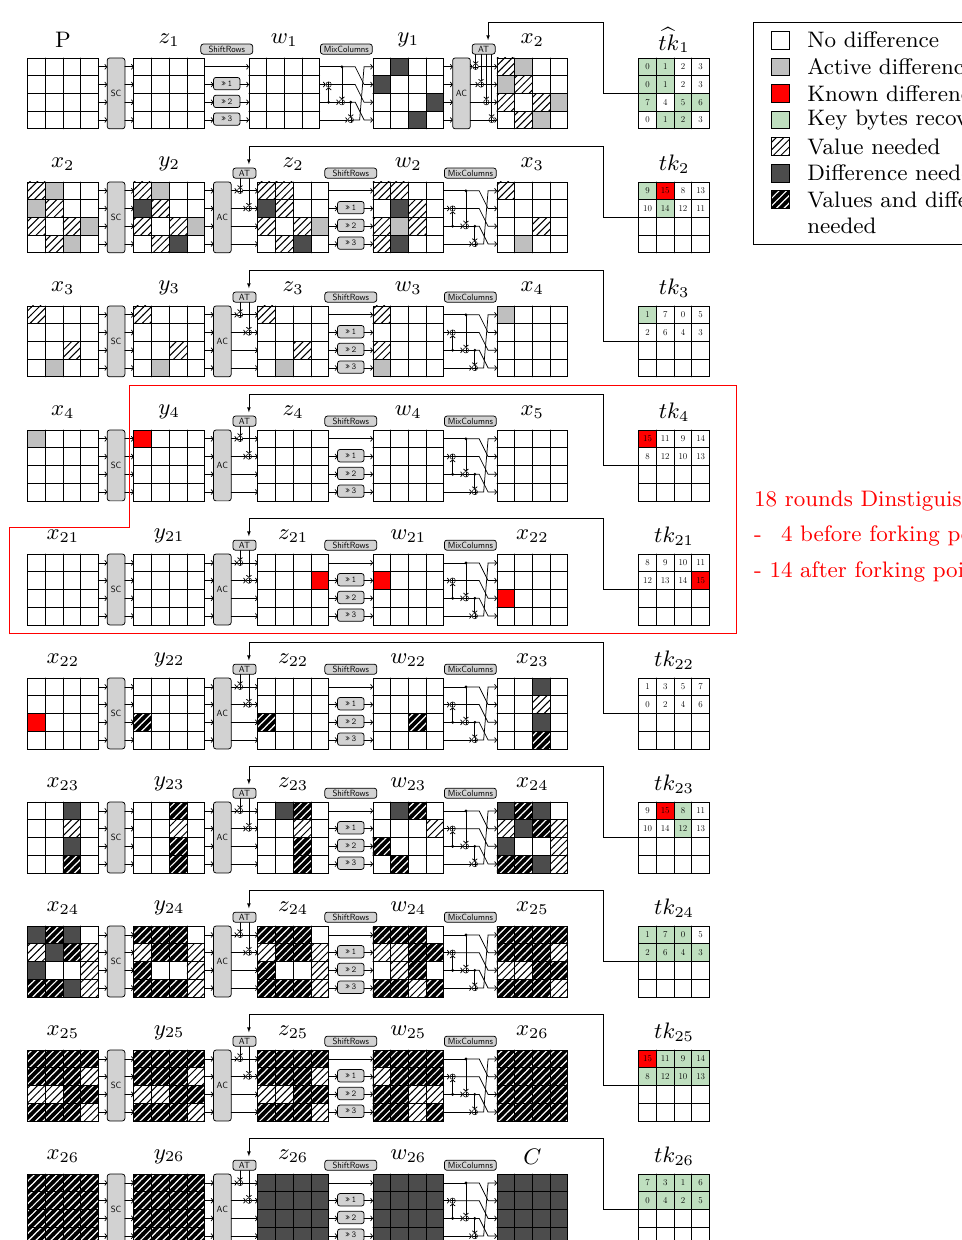
Figure 9: Tweakey recovery of the impossible differential attack of ForkSkinny-128-256 on 26